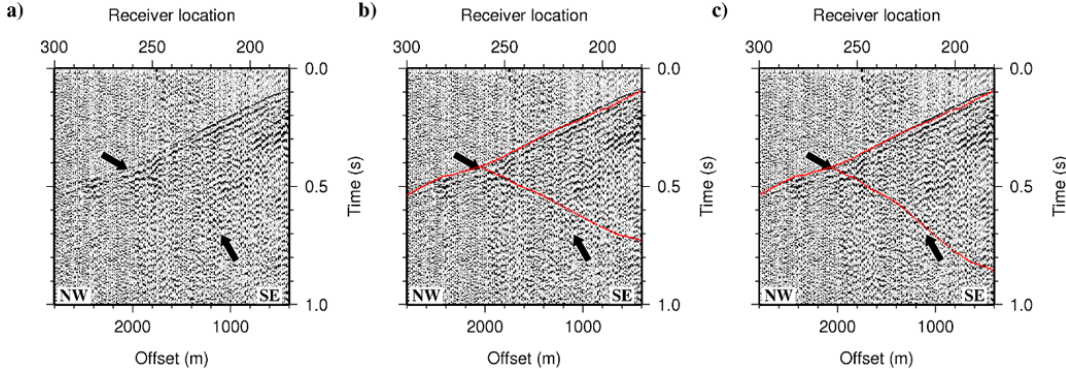
Fig. 9. Comparison of travel-time modeling of reflection S1. (a) without travel-time modeling (b) P-P reflection from a steeply dipping boundary strike 55 ◦ and dip 80 ◦ . (c) P-S reflection from a boundary with strike 55 ◦ and dip 55 ◦ (same geometry as for reflection R1).